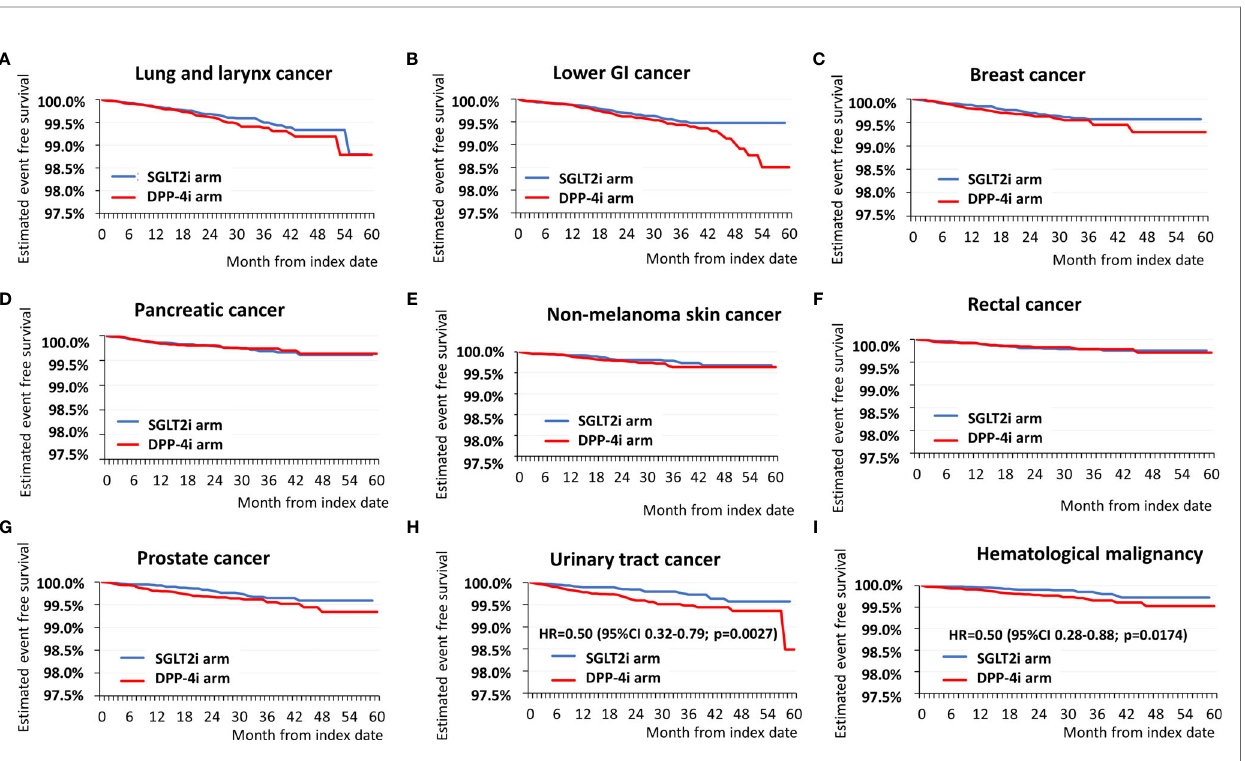
FIGURE 2 | Kaplan-Meier survivalcurves of selected cancer sites: (A) lungandlarynxcancer, (B) lower GI tract cancer, (C) breast cancer, (D) pancreaticcancer, (E) non- melanoma skin cancer, (F) rectal cancer, (G) Prostatecancer, (H) urinarytract cancer, (I) hematological malignancies. The blue curves show cancer-free survivalin the SGLT2i arm, the red curves the cancer-free survival inthe DPP-4i arm. In case of signi fi cant difference in hazard, also the exact hazardrates, 95% con fi denceintervalsand p values are presented.It must benoted that the axisof survivalisonthe same scale for each graph, enablingvisual comparisonsofcurves ofdifferent cancer